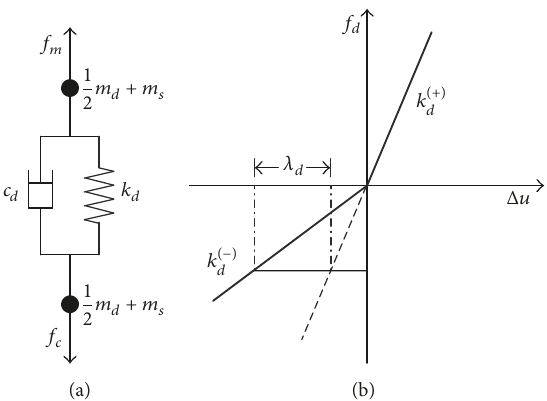
Figure 4: A model of a dropper: (a) a bilinear mass-spring-damper and (b) the constitutive relation of the